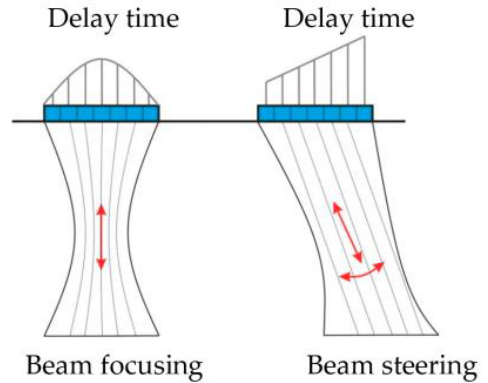
Figure 6. Phased array with angled wavefront [112].